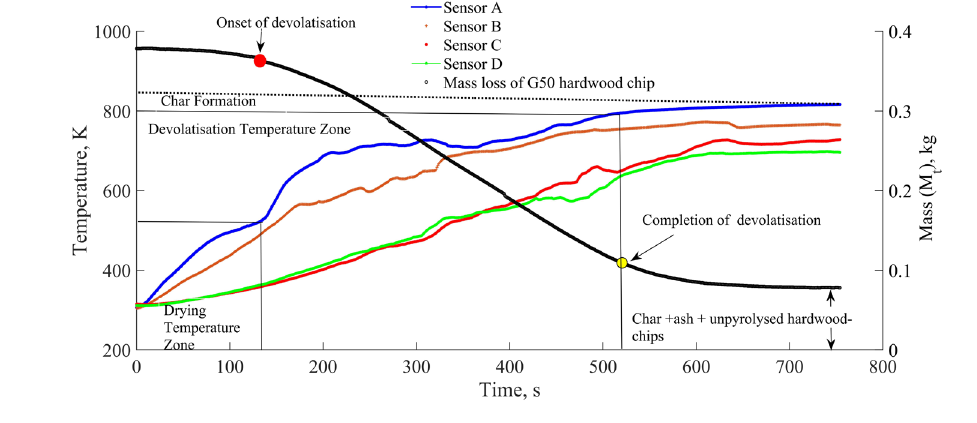
Fig. 4. Thermogravimetric variation of G50 Hardwood chip and the thermal history of the reactor with respect to